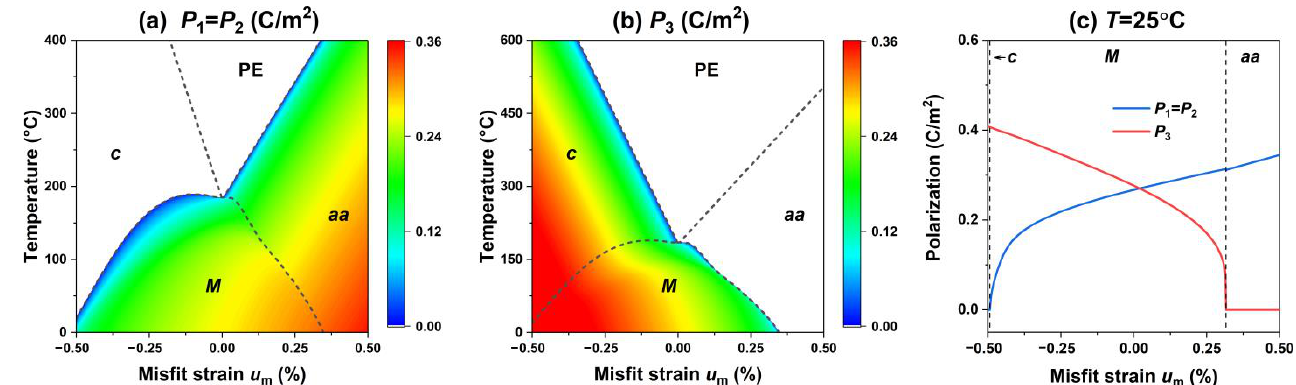
Figure 1. ( a , b ) The misfit strain-temperature phase diagrams in the absence of external electric field, and the corresponding ( a ) in-plane polarization components P 1 , P 2 , and ( b ) the out-of-plane polarization components P 3 . ( c ) The corresponding polarization components as functions of misfit strain u m at room temperature. The color bar illustrates the value of polarization.